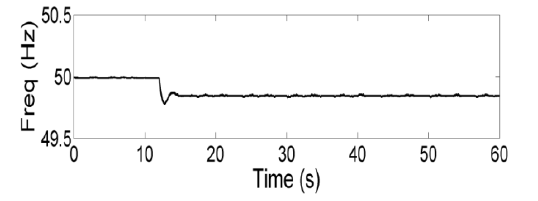
Figure 19. Frequency response during the load change.